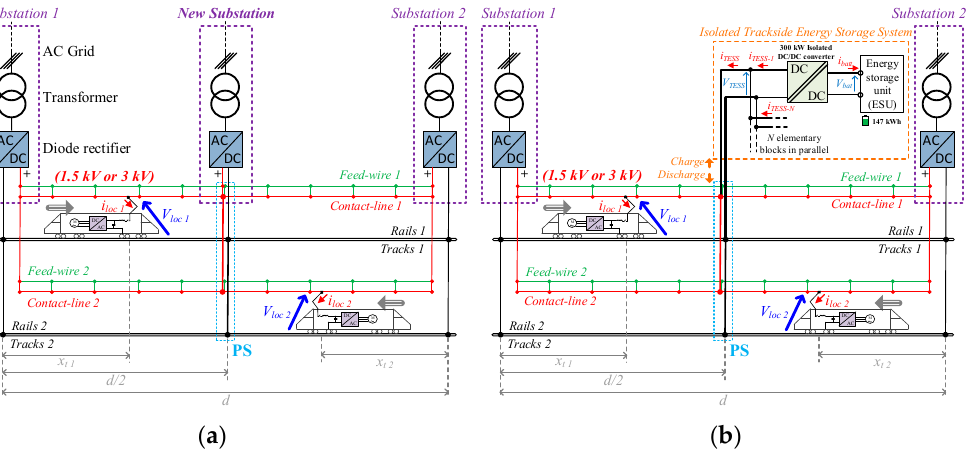
Figure 7. Solutions to reduce voltage drops: ( a ) double-track line equipped with a new substation at PS; ( b ) double-track line equipped with an isolated trackside energy storage system at